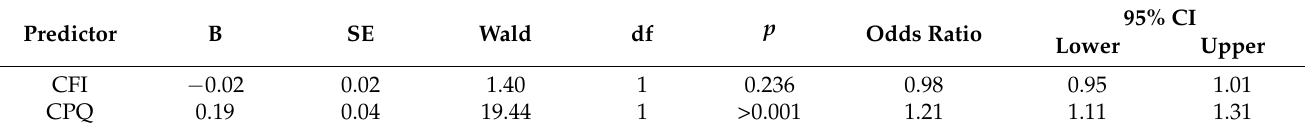
Table 2. Model of CFI and CPQ predicting